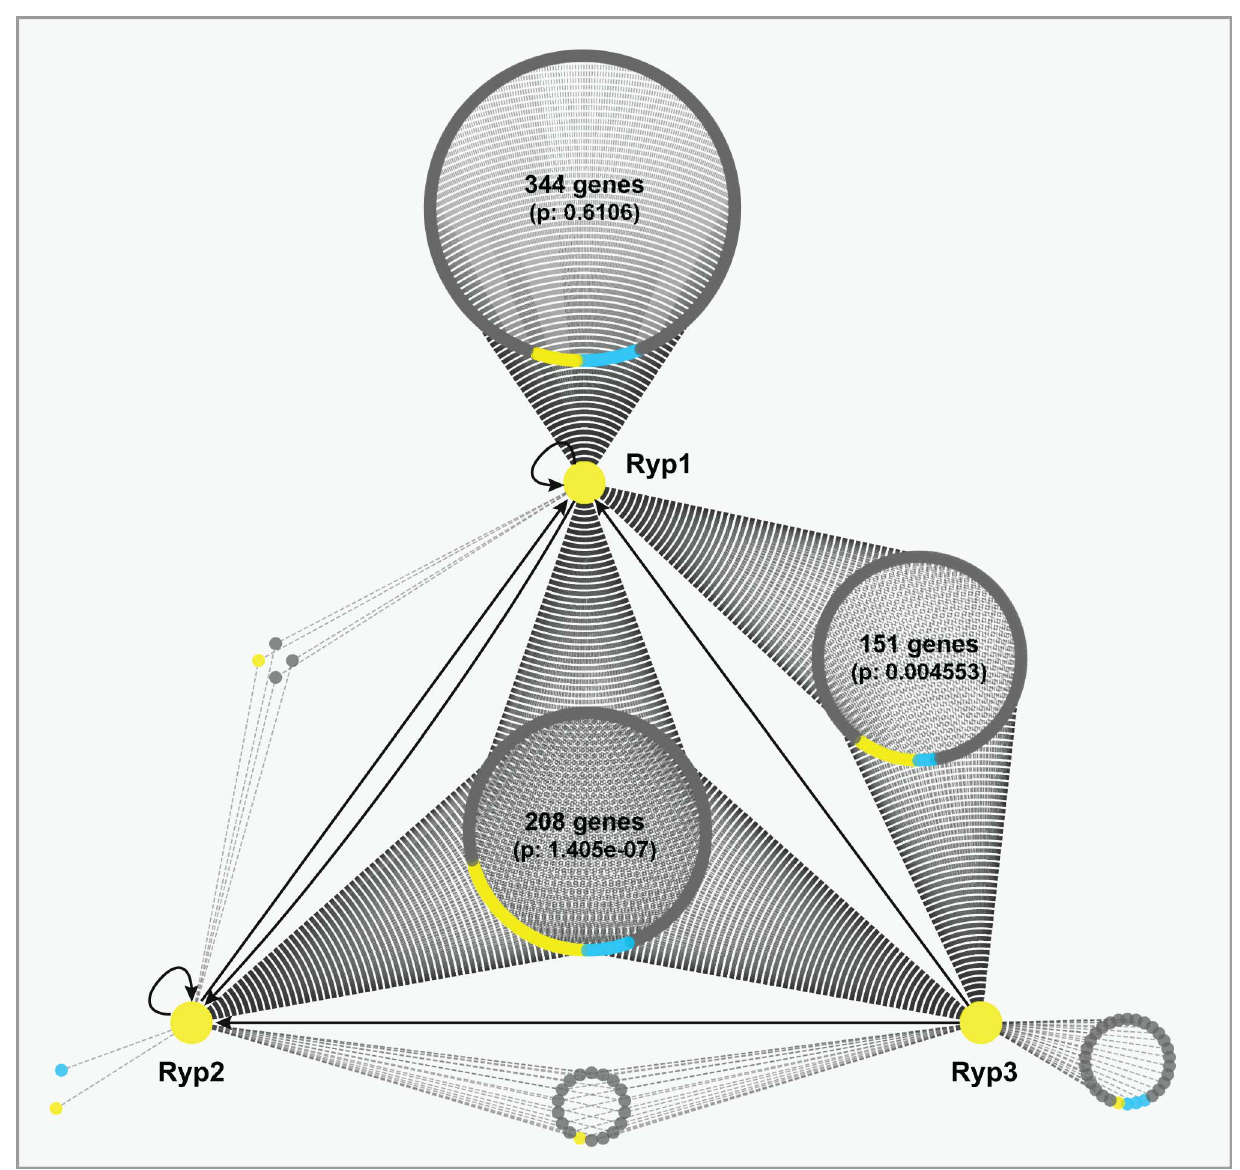
Figure 2. Ryp factors associate upstream of similar sets of genes. A network view of ChIP targets was generated using Cytoscape. Each large circle is composed of individual closed circles, each of which represents an individual target gene. YPS genes are colored in yellow, and FPS genes are colored in blue. The distribution of YPS and FPS genes in each category of ChIP targets (e.g., shared targets of Ryp1, 2, and 3) was compared to the whole genome (Figure S5) using the Wilcoxon test. The p values obtained in this analysis are shown. Additionally, targets shared by Ryp1 and Ryp3, as well as targets shared by all three Ryp factors, were enriched for YPS genes ( p value , 0.001) as determined by hypergeometric tests performed in